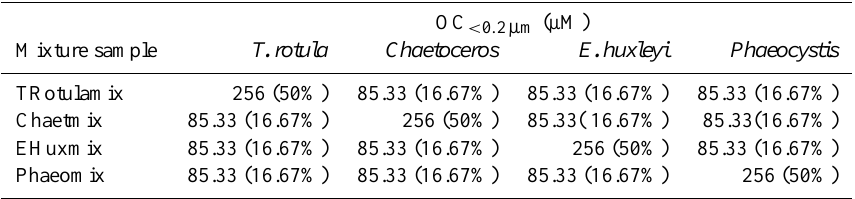
Table 3. Contribution of single algal exudates to the total organic carbon content of seawater proxies enriched with exudates mixtures (total OC < 0 . 2 µ m =512 µM).